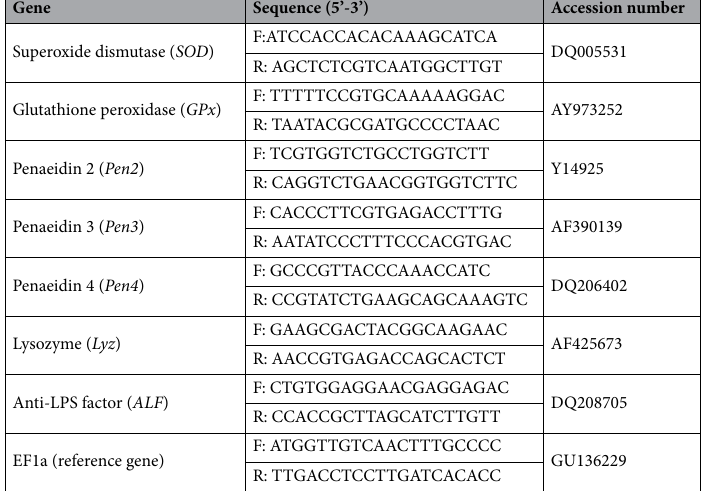
Table 2. Primers used for immune-related gene